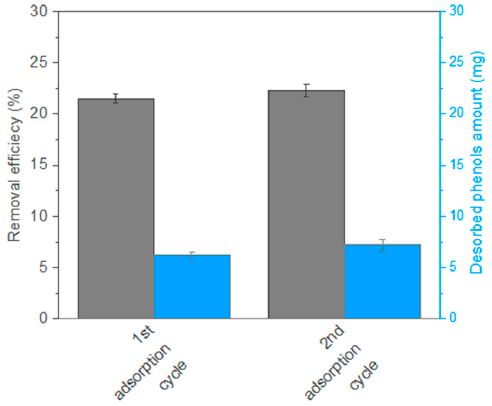
Figure 9. Reusability tests for PDMS/oxMWCNTs sponges reporting removal efficiency % (gray column) and the amount of desorbed phenols (blue